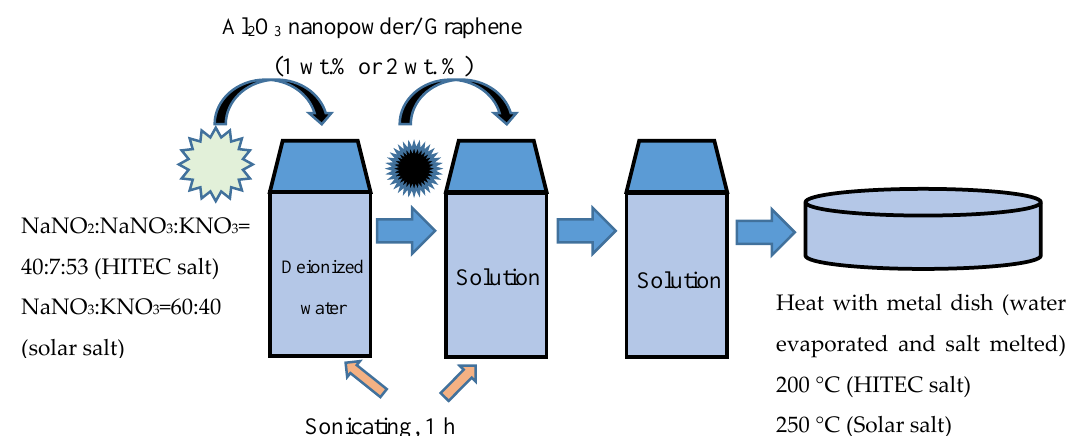
Figure 1. Synthesis of nanocomposite with liquid dissolution method. A HITEC salt/nanoparticle nanocomposite was synthesized under the heating temperature of 200 °C, while a solar salt/nanoparticle nanocomposite was heated at 250 °C.